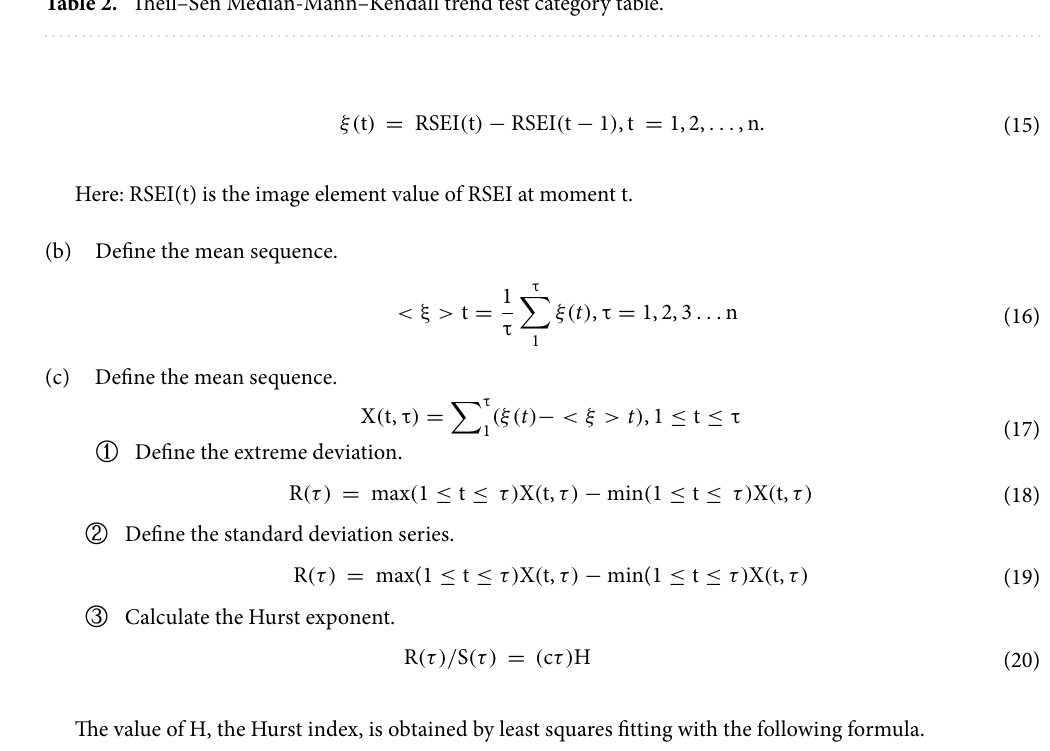
Table 2. Theil–Sen Median-Mann–Kendall trend test category